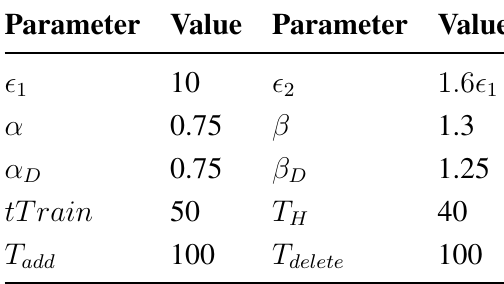
Table 1. Parameters selected for the proposed